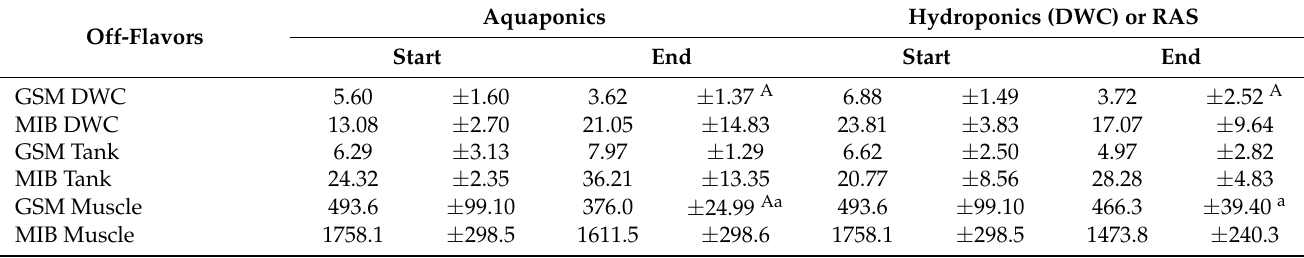
Values are means ± SD, n = 3 for end samples and 2 for start samples. The superscript letter “ A ” indicates statisti- cally significant difference ( p < 0.05) between the sampling points and “ a ” between the treatments (aquaponics vs.